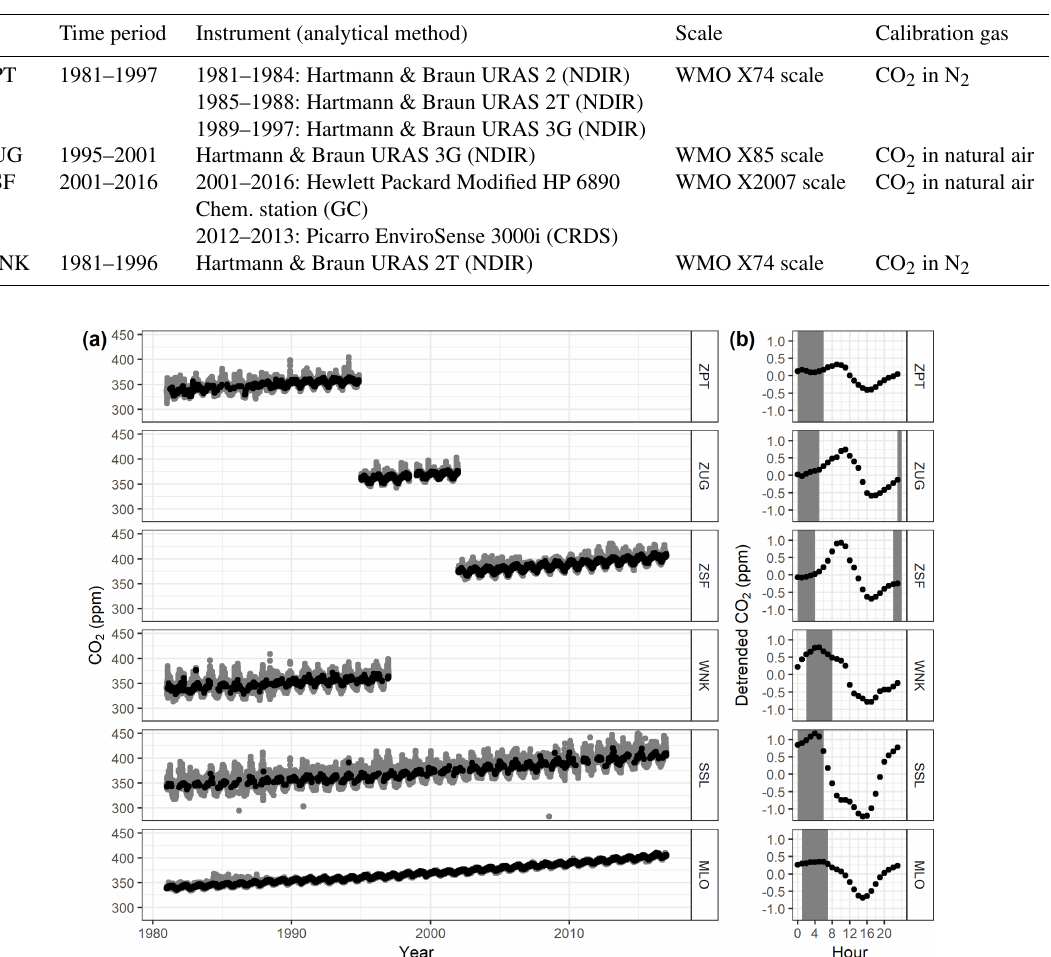
Table 1. Detailed description of atmospheric CO 2 measurement techniques (NDIR is the nondispersive infrared, GC is gas chromatography, and CRDS is cavity ring-down spectroscopy). At ZSF, CO 2 data from GC measurements were not available from 2012 to 2013 due to an instrumental failure; thus data from CRDS measurements were used in these 2 years for this study. However, CRDS measurements were performed in parallel from the same air inlet from 2011.